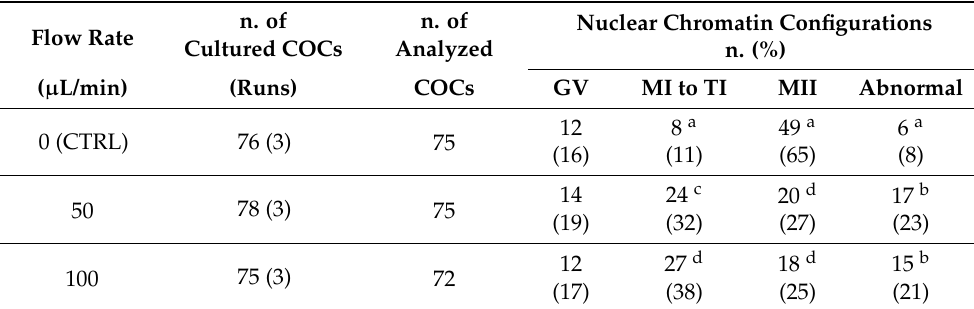
Table legend: GV: Germinal Vesicle; MI: Metaphase I; TI: Telophase I; MII: Metaphase II. Chi square test: